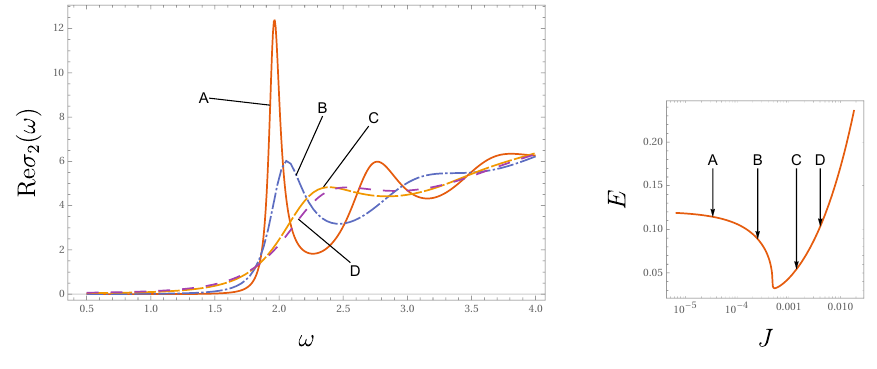
Figure 5 . (Left) AC conductivity, (Right) J - E characteristic at T = 0 . 34364 . The value of J for each curve in the left figure are corresponding to those labeled by A to D on the J - E